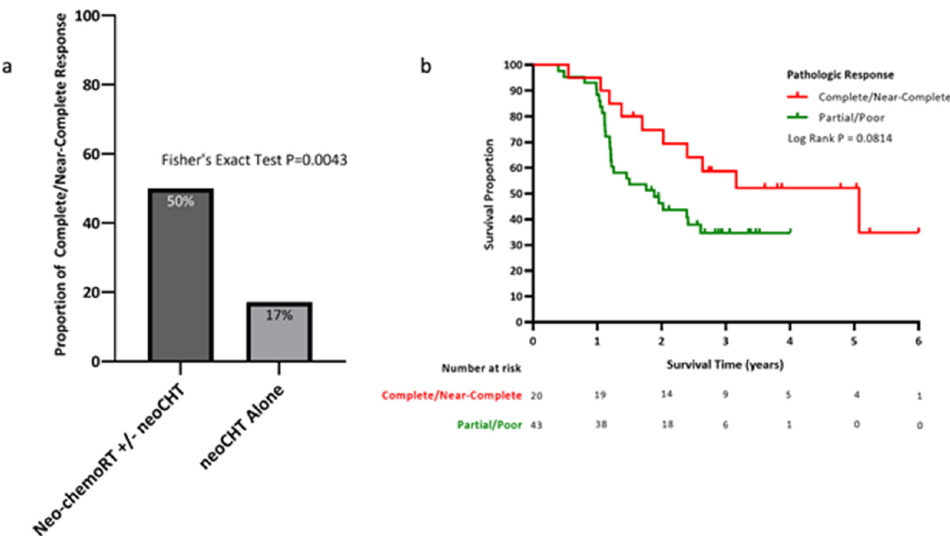
Figure 2. Neo-chemoRT is associated with increased pathologic response rates compared to neoCHT alone. Figure demonstrates ( a ) increased rates of “complete or near-complete response” in those who received neo-chemoRT +/ − neoCHT versus neoCHT alone and ( b ) improved median OS in complete/near-complete responders. Table 3. Comparison of hospital LOS, early and late complications, and early and late readmission rates between patients who underwent NAT versus no